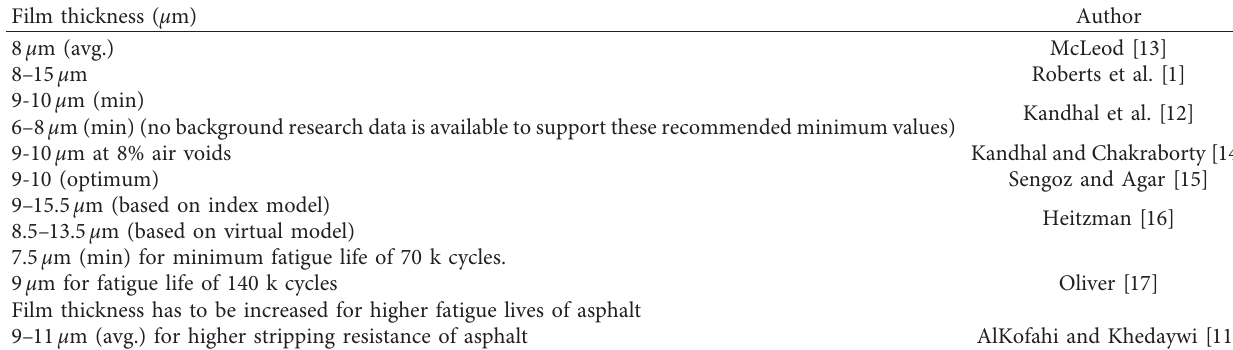
Table 1: Recommended asphalt binder film thicknesses for HMA.